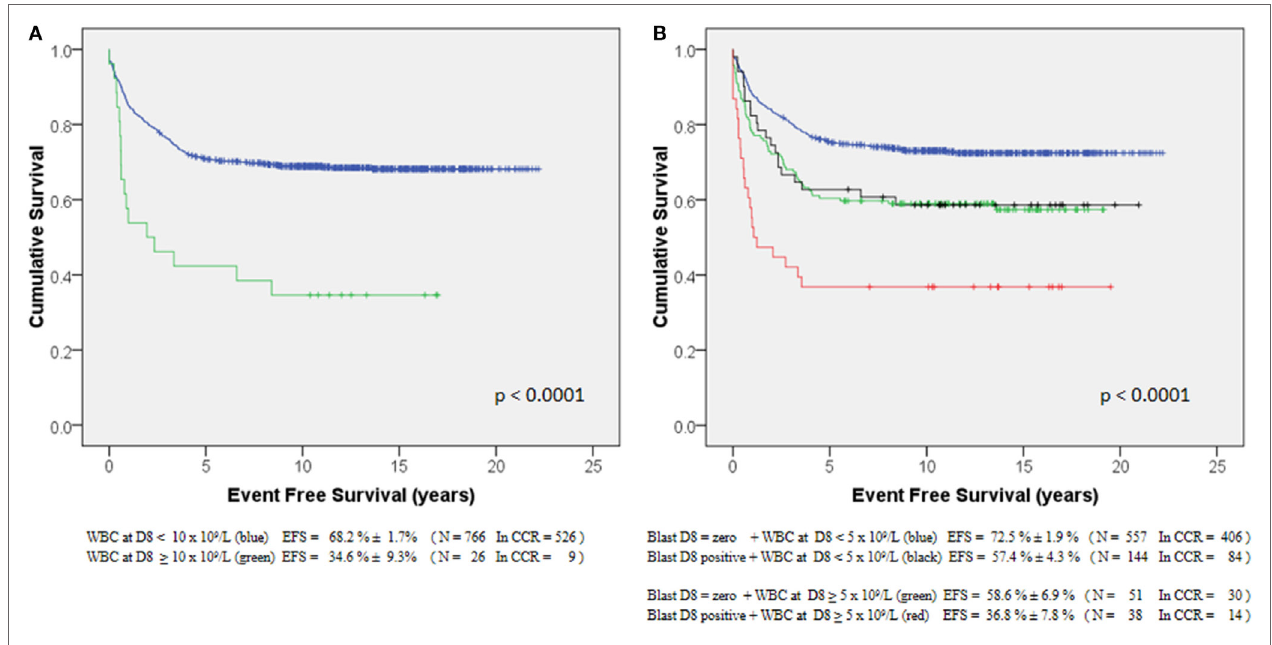
FigUre 3 | event-free survival of 853 all-children treated by gBTli all-93 protocol related to initial induction therapy response (at D8): (a) according to peripheral WBc counts, (B) according to the presence of any blast and WBc counts